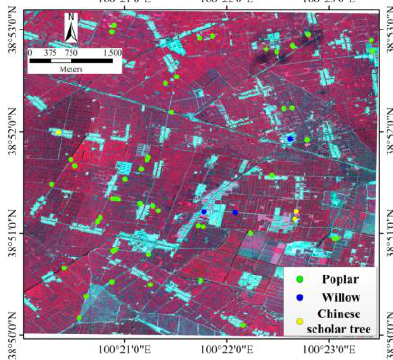
Figure 2. Spatial distribution of the measured trees for three tree species: poplar, willow and Chinese